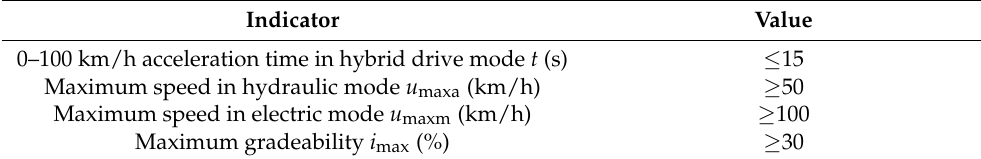
Table 2. Vehicle performance indicators.